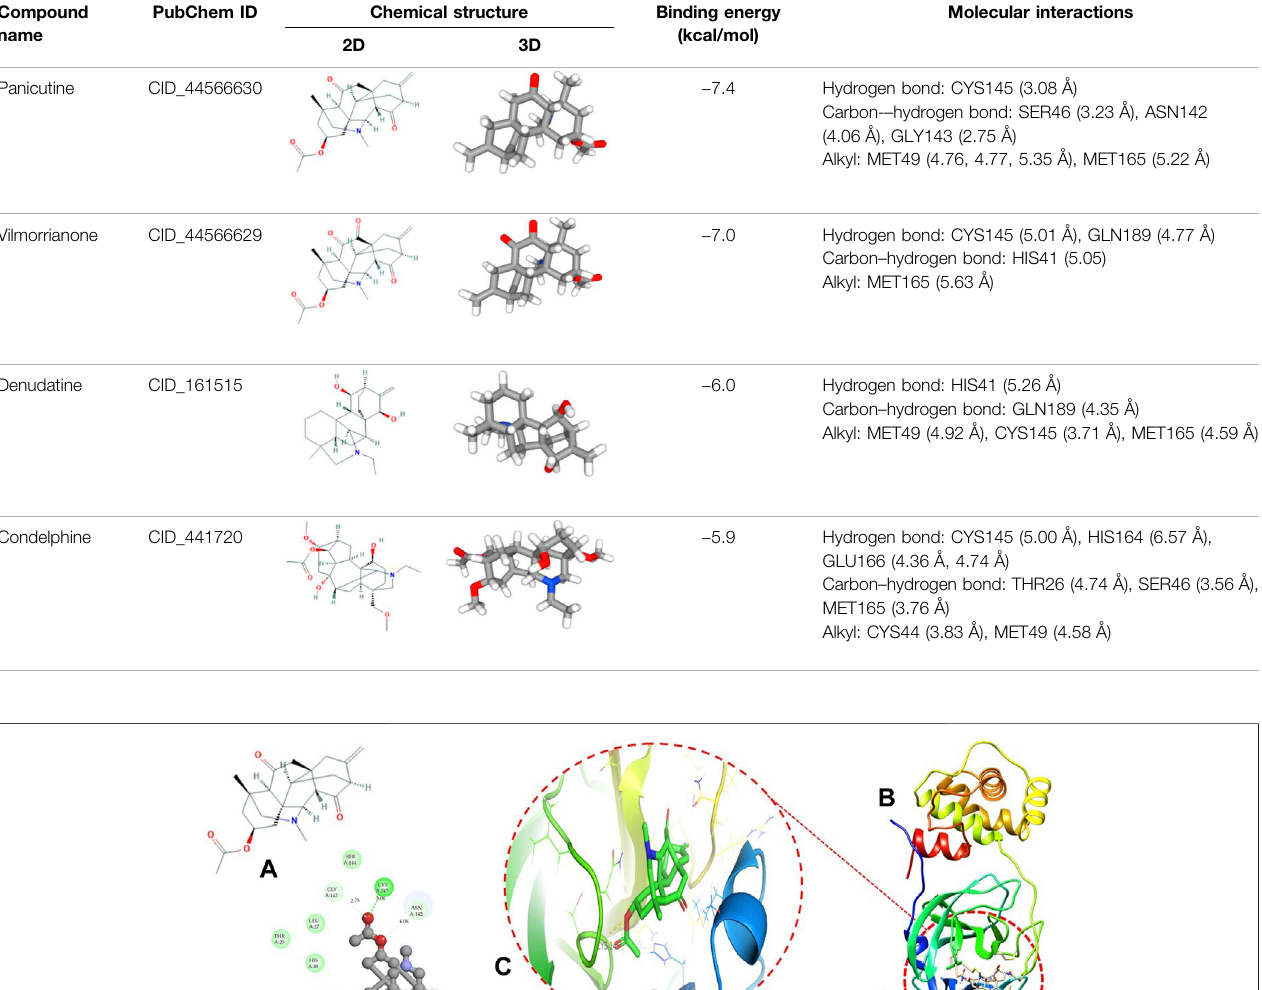
TABLE 1 | Details of molecular docking of Jadwar-derived alkaloids against the main protease of COVID-19.